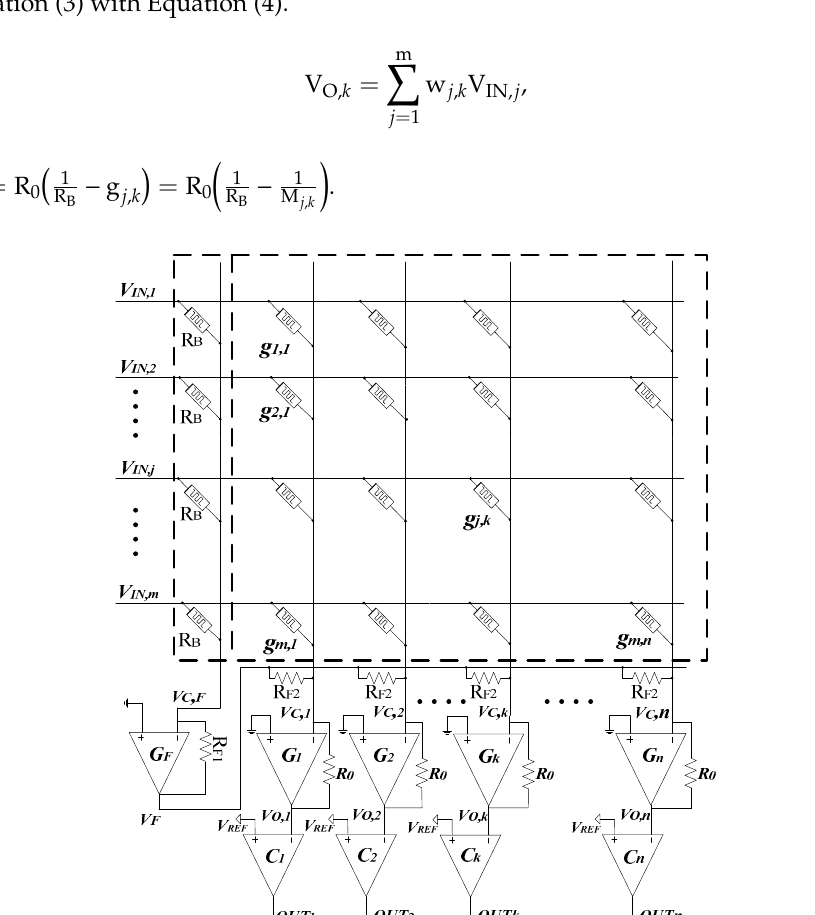
Figure 1. The memristor-based crossbar architecture with a single memristor array and a constant-term circuit for realizing the synaptic matrix of a perceptron neural network [21].